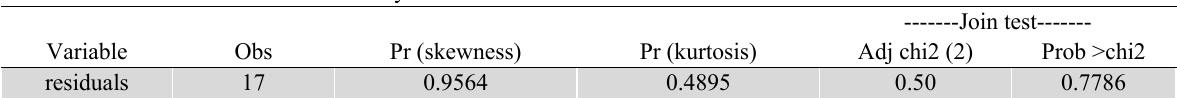
Normality test to ARDL (1,2,4,4) model Skewness and kurtosis tests for normality